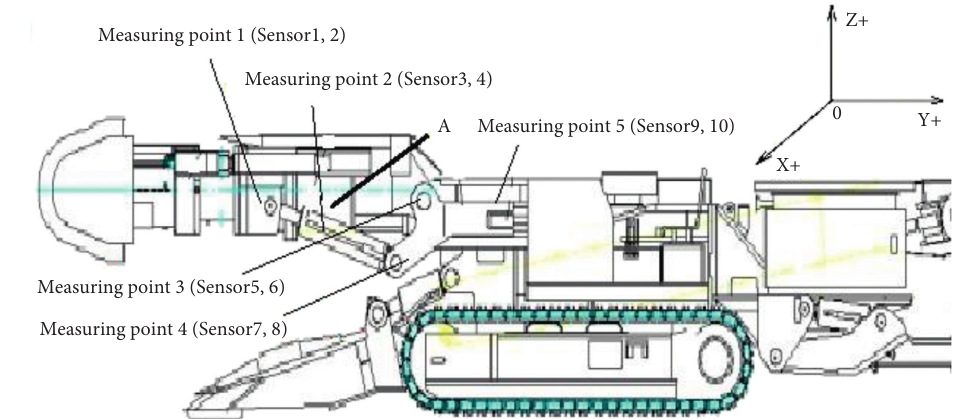
Figure 6: Arrangement drawings of the roadheader’s measuring point. Table 1: Corresponding relation of vibration sensor.